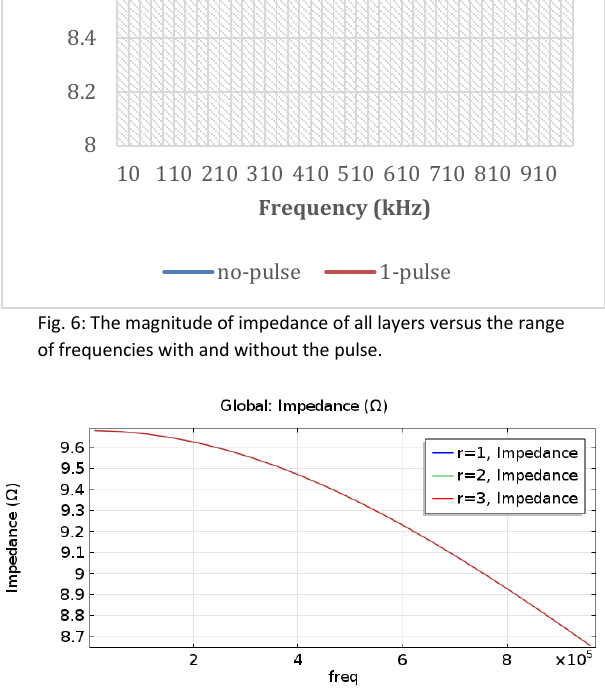
Fig. 7: The magnitude of the impedance of all layers versus range of frequencies at different values of blood